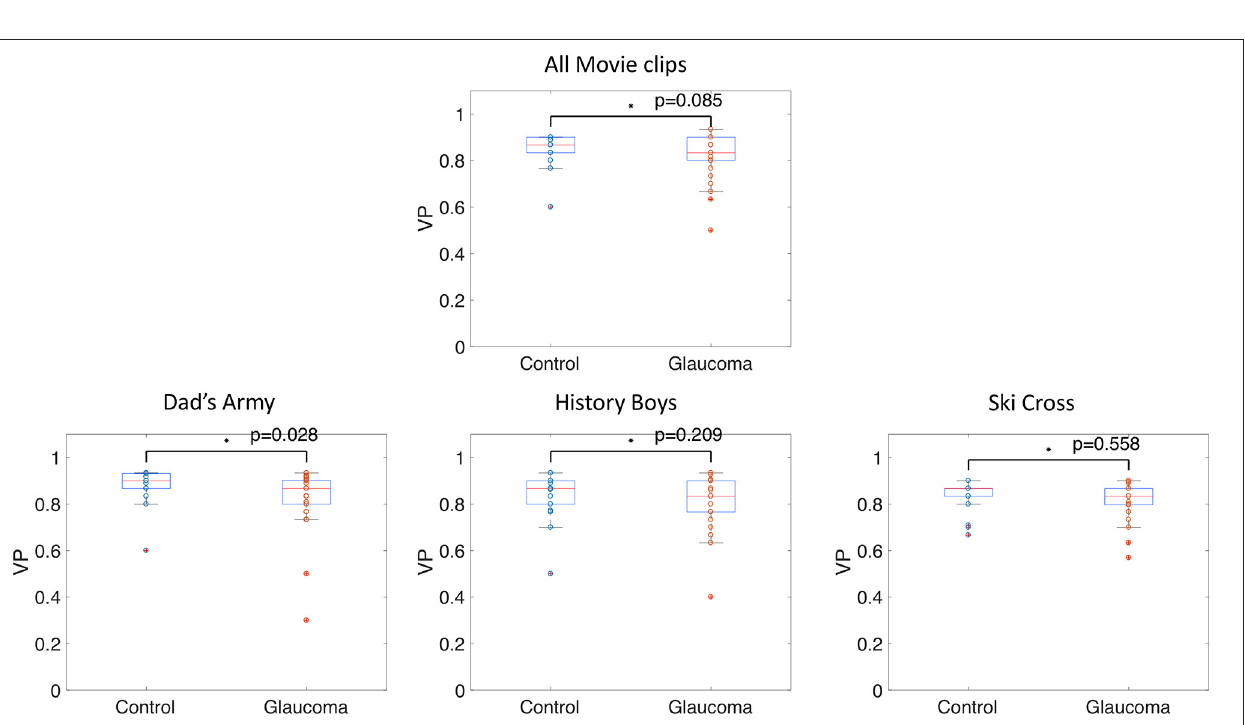
FIGURE 10 | maximum of the saccade amplitudes of the control group, per direction. The second figure in this column shows the normalized rank that the saccade amplitude of the patient occupies among the saccade amplitudes of the controls per direction, with the red lines representing boarders at which the rank is above or below the upper and lower 2.5% of the control group. The fourth column shows the same as the third column for the maximum saccade amplitudes (A) Examples of median and maximum saccade amplitudes of four different patients, who had peripheral VFD in their IVF. (B) Examples of patients with VFD in the upper part of the visual field. (C) Patients with a VFD which also reached the central part of the visual field. (D) Examples of patients with large VFD in the periphery of the visual field. While the first and third patient in this panel showed median and maximum saccade amplitudes which were close to those of the controls, the second one showed high median saccade amplitudes toward the most intact, but also toward the most damaged area of the visual field.